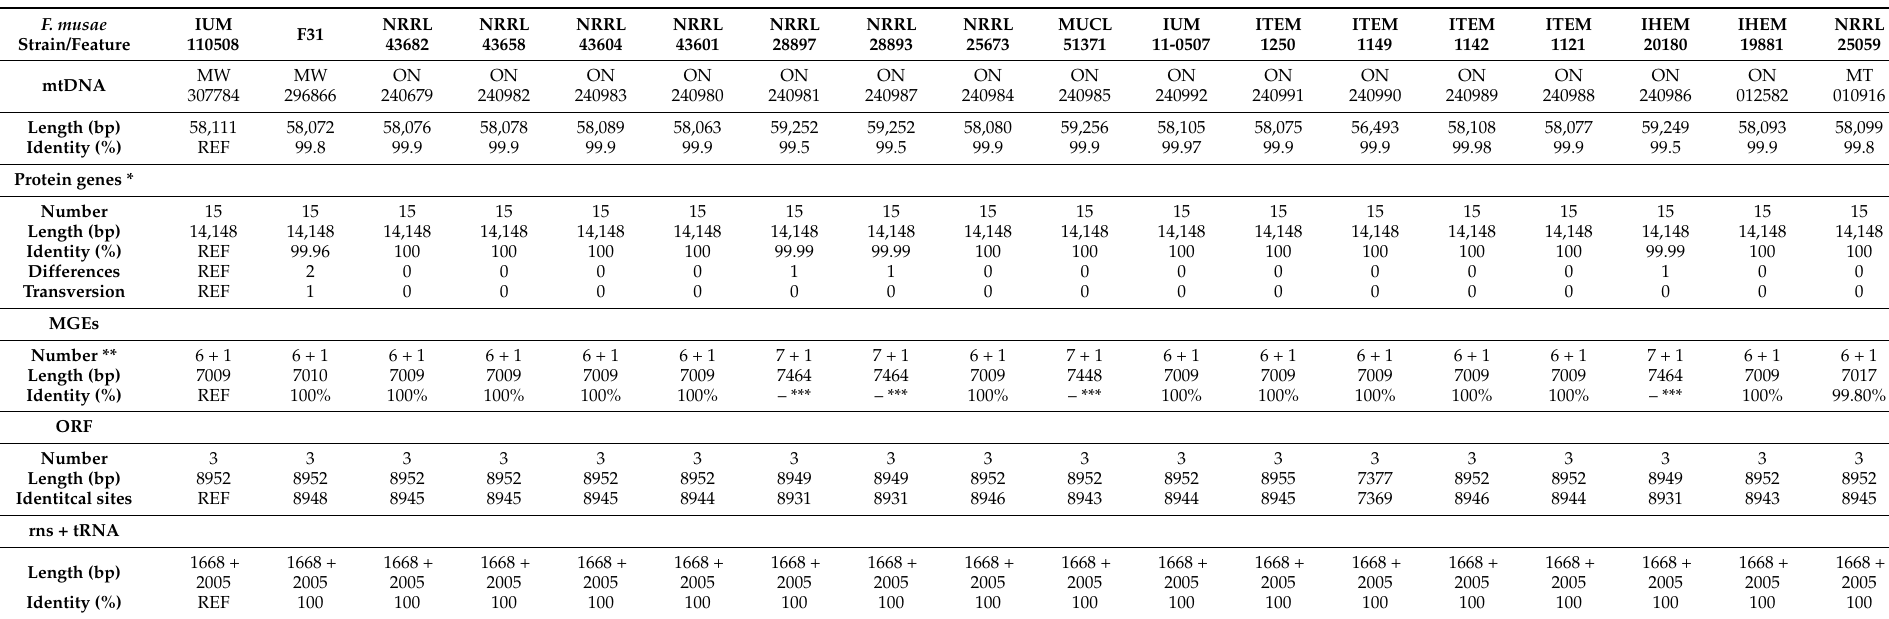
Table 1. List of F. musae strains used in this study with GeneBank accession numbers and mitogenome size and